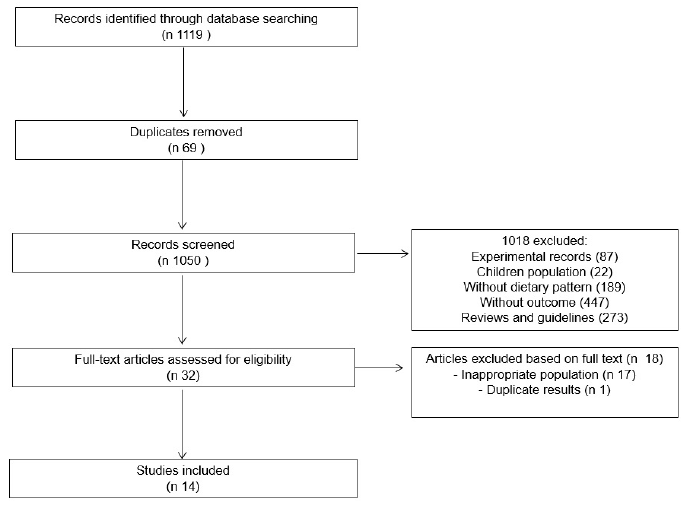
Figure 1. Flowchart for selection of articles.